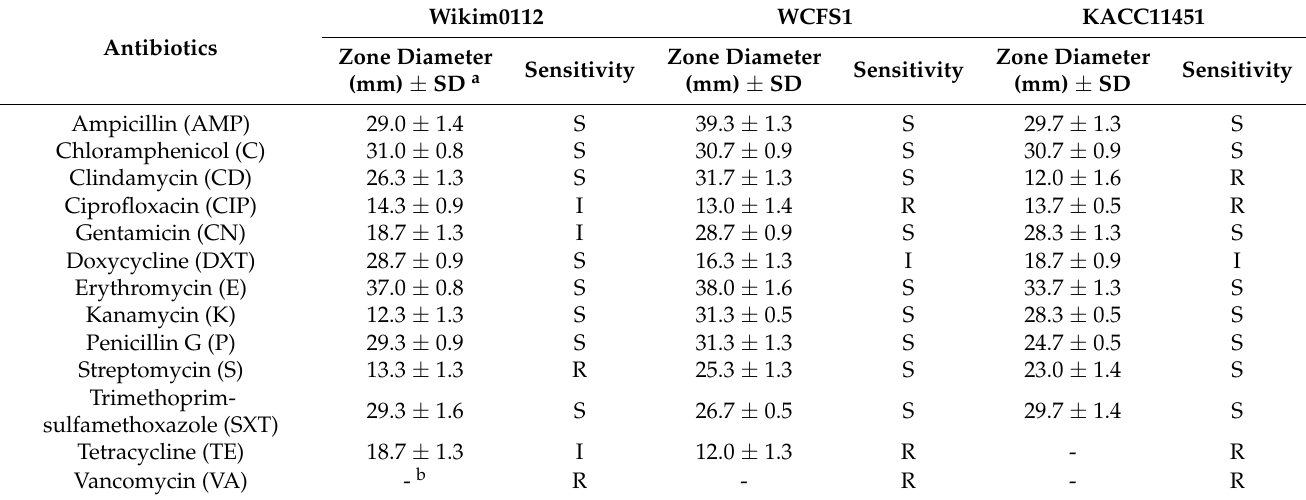
Table 3. Antibiotic susceptibility of Lpb. plantarum Wikim0112, WCFS1, and